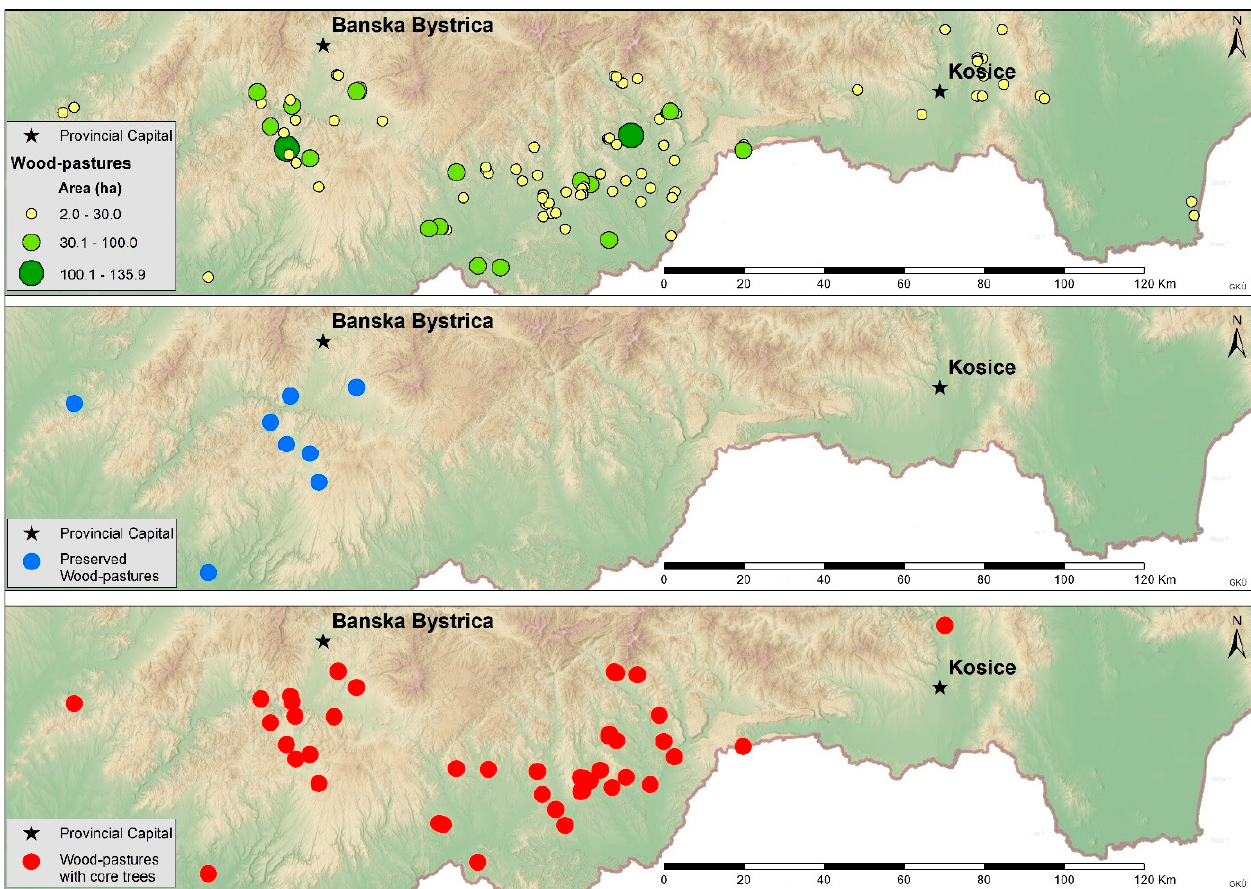
Figure 2. Detail of historical and present state of wood pastures: (i) historical wood-pasture area and distribution (top); (ii) preserved wood pastures (middle); and (iii) abandoned wood pastures with high restoration potential and preserved veteran trees (bottom).